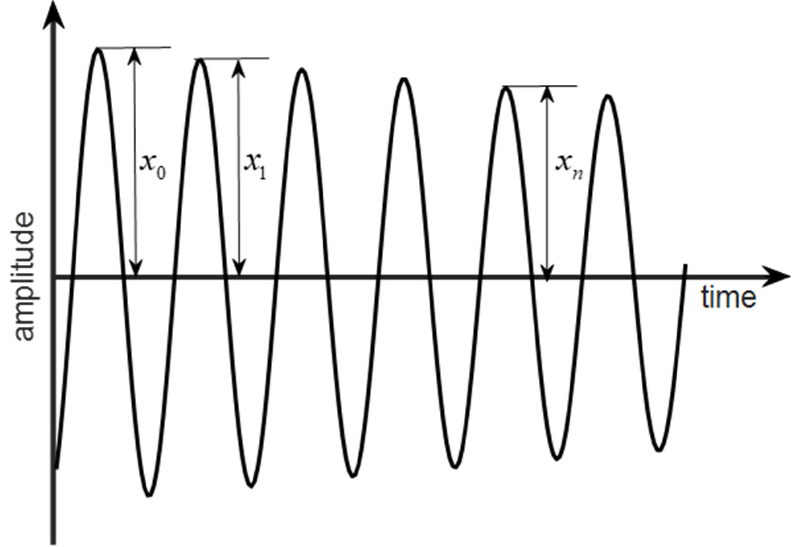
Figure 16. Vibration attenuation.